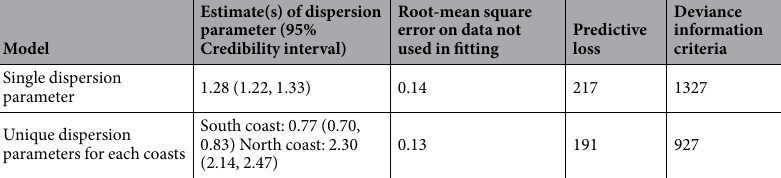
Table 1. Fit statistics from the two Vanua Levu models. North coast includes Bua